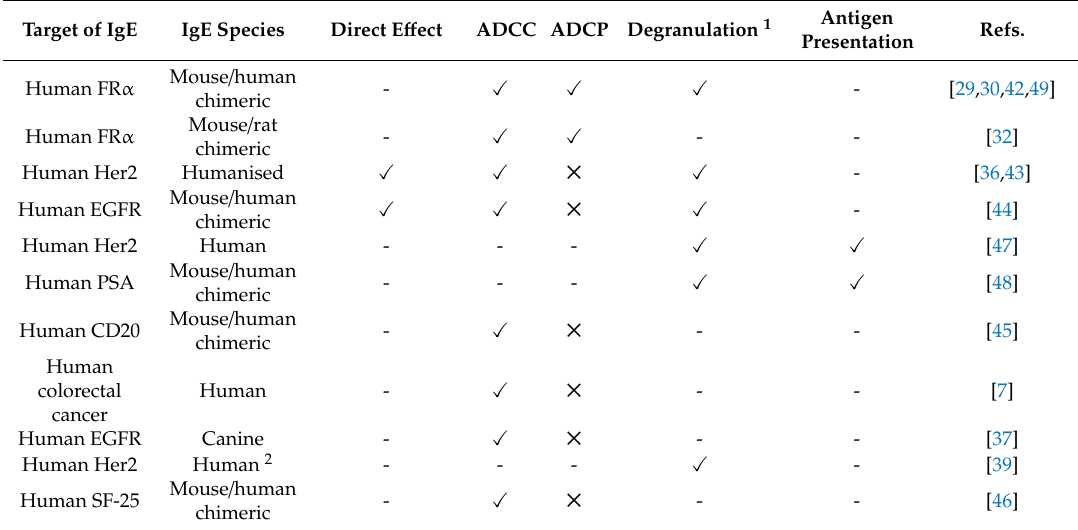
Table 1. In vitro studies of IgE antibody therapy e ffi